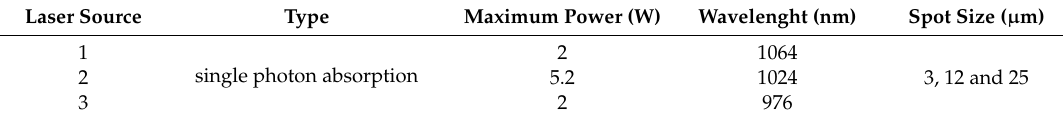
Figure 3. ( a ) DC resistive switching behavior during successive SET and RESET operations; and ( b ) High resistancestate(HRS)andlowresistancestate(LRS)extractedfromtheDCresistiveswitchingbehavior.at − 0.1 V and + 0.1 V, respectively. Table 2. Information about the laser sources considered in this work.